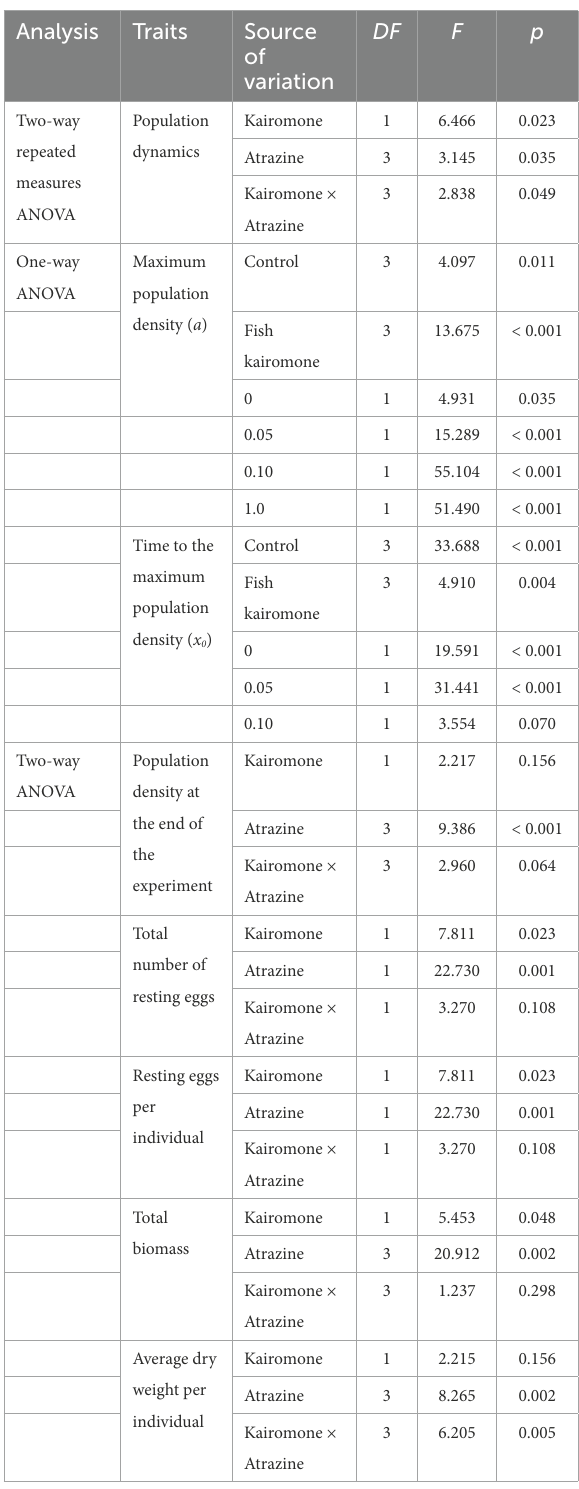
TABLE 1 The results of two-way repeated measures ANOVA on population size, the two-way ANOVA on population traits, the one- way ANOVA on parameters of the three-parameter Gaussian model on the different conditions, and the one-way ANOVA on different DMSO